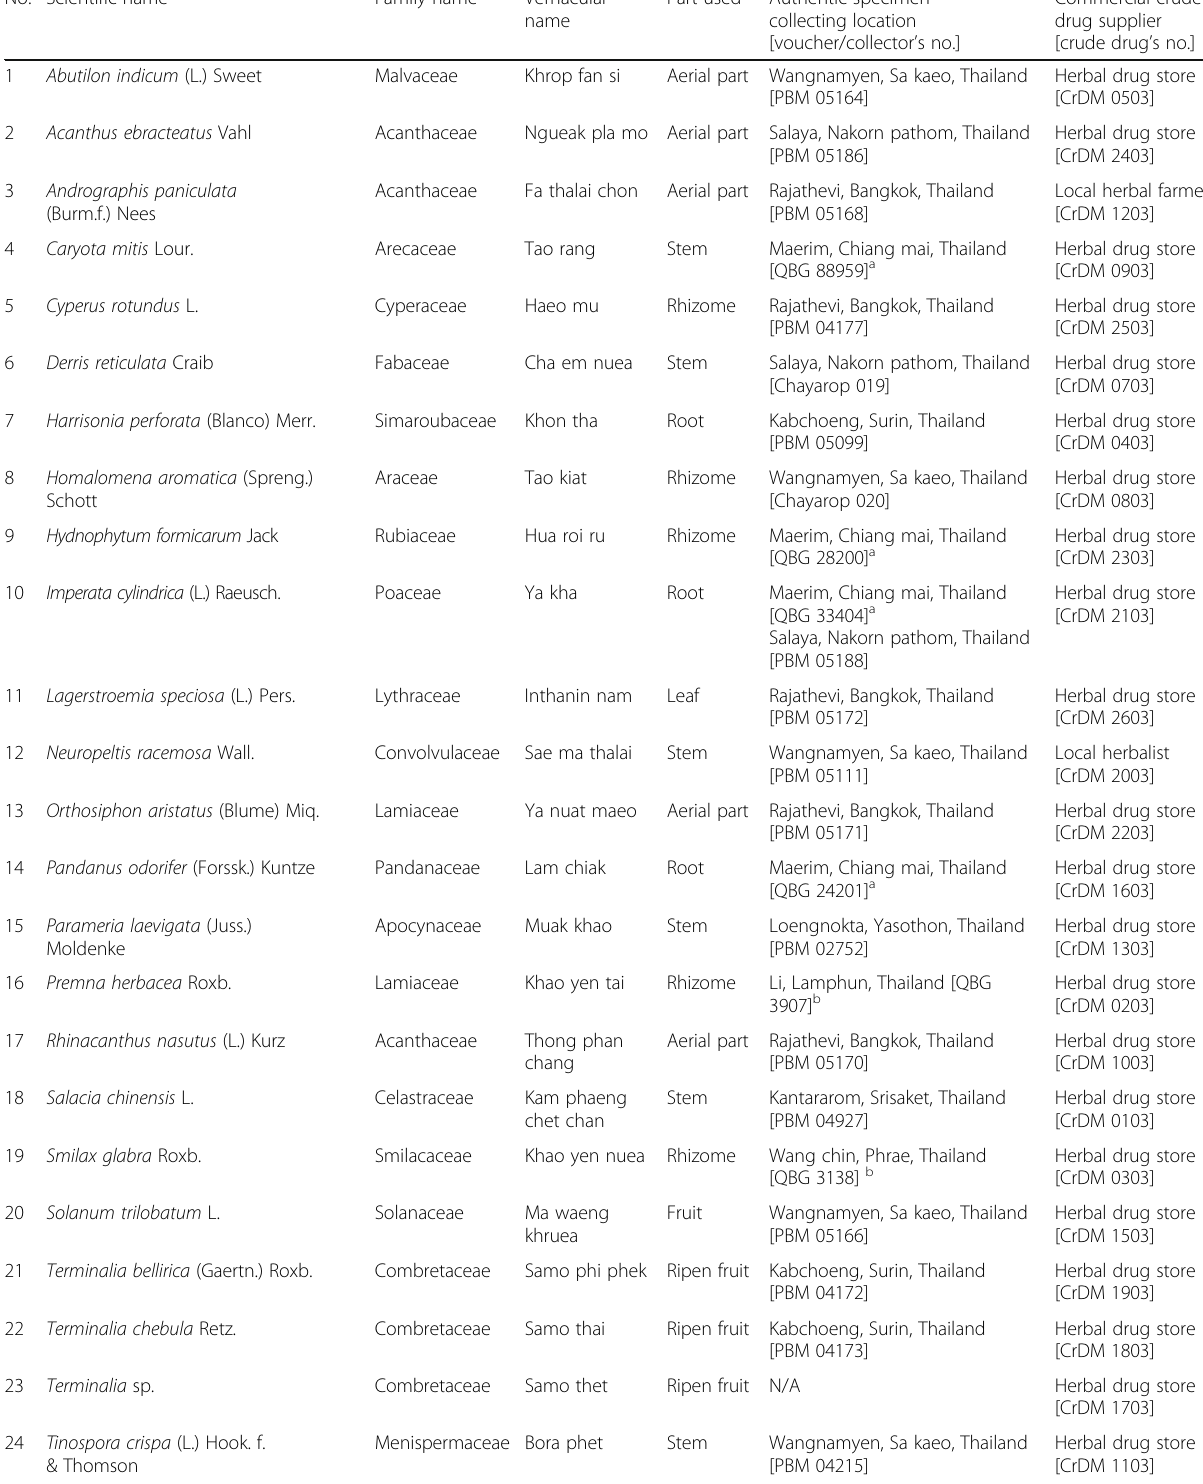
Table 1 List of the 26 component herbs of the Mathurameha herbal